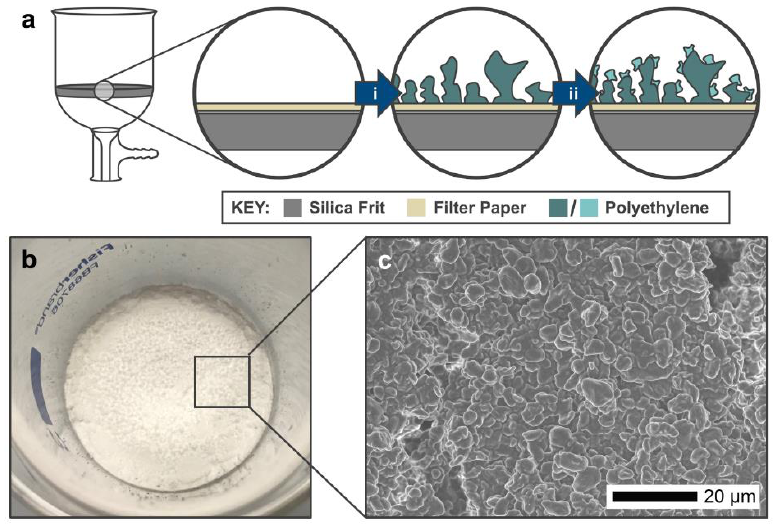
Figure 1. ( a ) A schematic showing the composition of the PE micropowder filters. The filter is constructed using a Buchner funnel/silica frit with a filter paper placed on top of the frit. The first layer ( i ) uses a heat treatment temperature of 140 °C, which forms a uniform base for the second layer ( ii ). The second layer uses a lower heat treatment (114 °C) which preserves the high surface roughness. ( b ) A digital photo of the filter made using S- µ sized PE powder. ( c ) An SEM image of the S- µ powder heated at 114 °C.